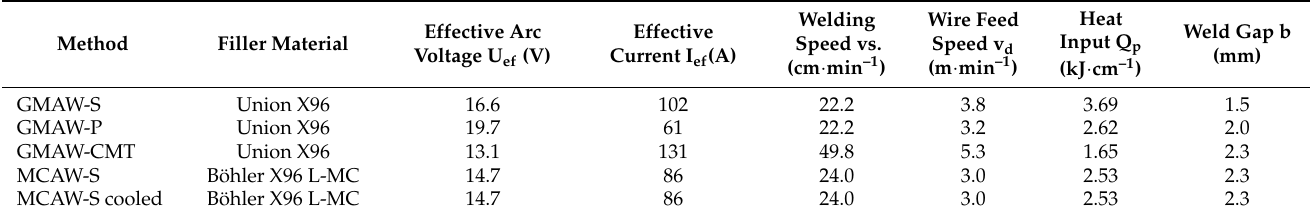
Table 4. Welding parameters of the assessed welded joints.